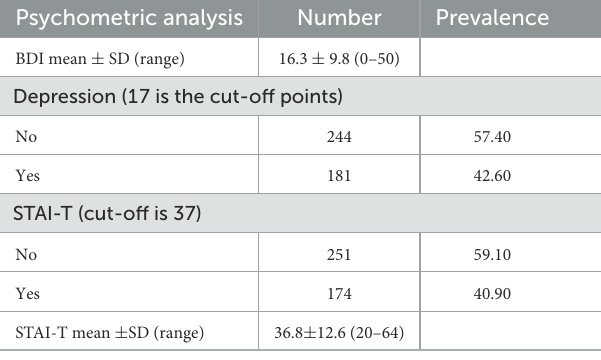
TABLE 2 Prevalence of depression and anxiety among patients with cancer ( n = 425). Psychometric analysis